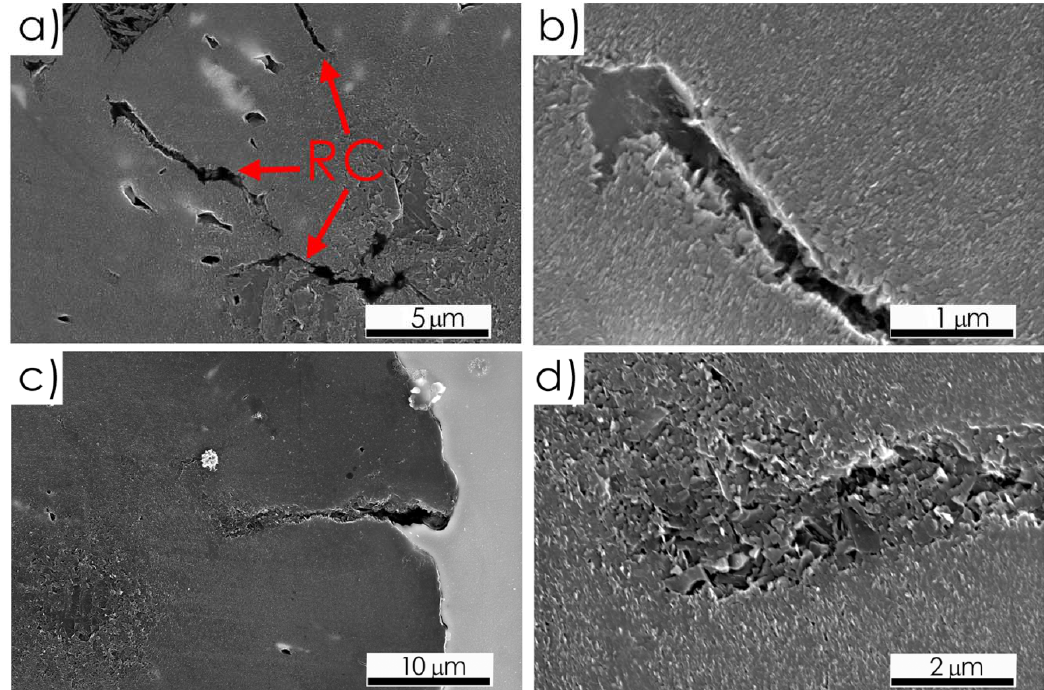
Figure 6. Radial cracks (RC) inside a graphite spheroid in SNi11 specimen, SEM: ( a ) Radial cracks (RC) initiated in the disgregation area at a distance of 1 mm from the fracture surface, ( b ) enlarged area visible in ( a ), ( c ) an intersectoral crack initiated in the outer layer of graphite nodule, near the G ‐ M interface, ( d ) enlarged area visible in ( c ).